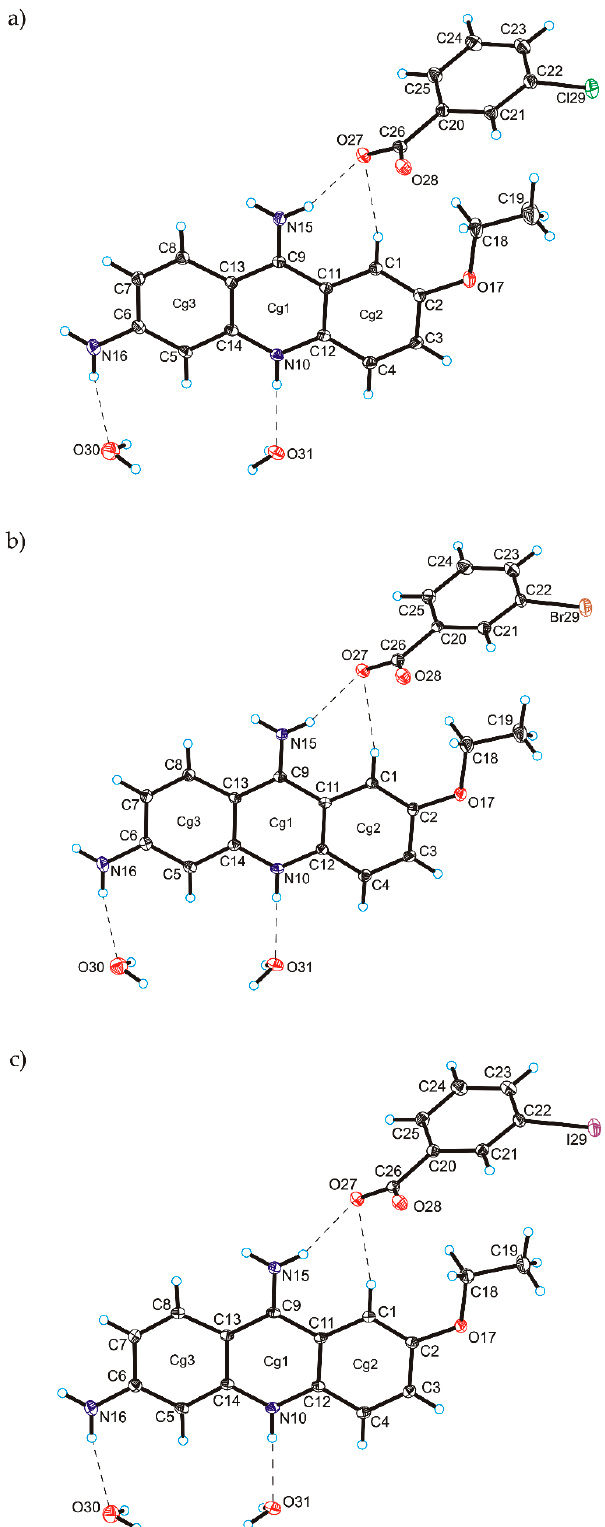
Figure 1. Molecular structures of compounds 1 – 3 in ( a – c ), respectively, showing the atom-labelling scheme. Cg1, Cg2 and Cg3 denote the ring centroids (hydrogen bonds are represented by dashed lines). Displacement ellipsoids are drawn at the 25% probability level and H atoms are shown as small spheres of arbitrary radius.